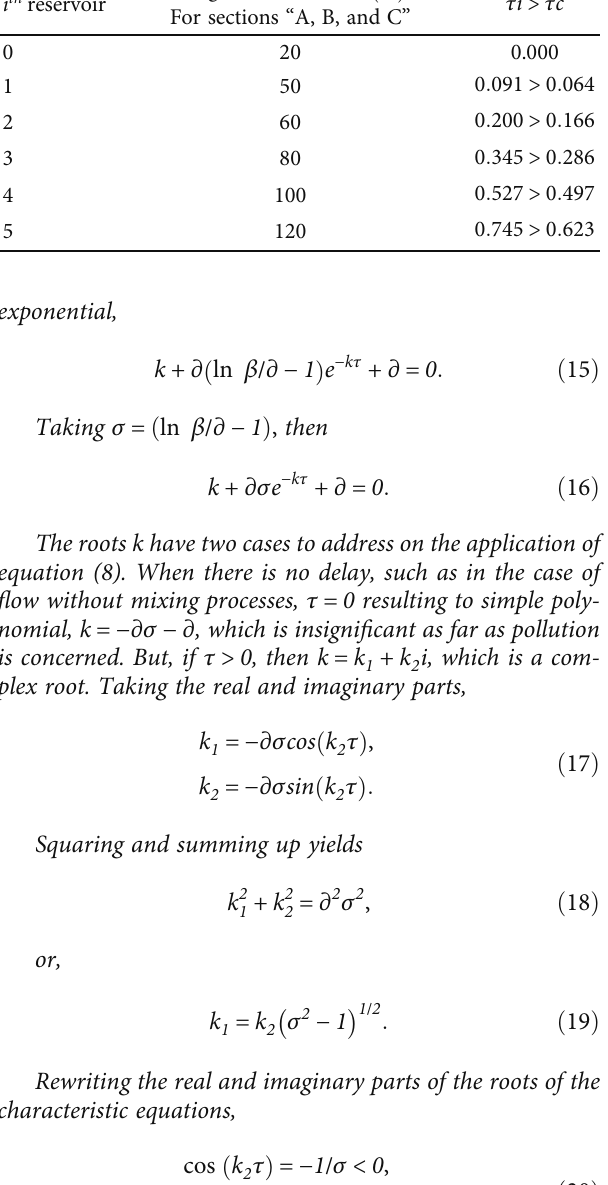
Table 1: Boundedness of delays, τ Length of reservoir, L m ð Þ i th reservoir For sections “ A, B, and C